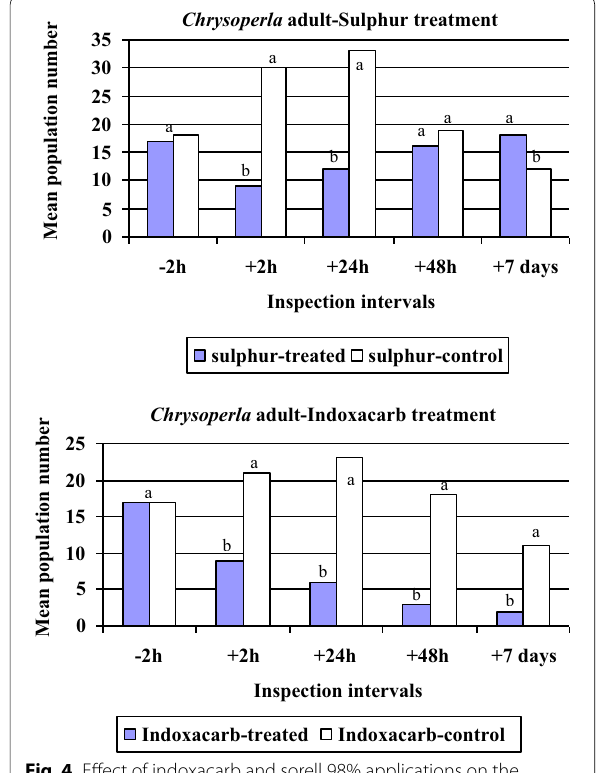
Fig. 4 Effect of indoxacarb and sorell 98% applications on the abundance of Chrysoperla adults. Significant differences were calculated separately for each